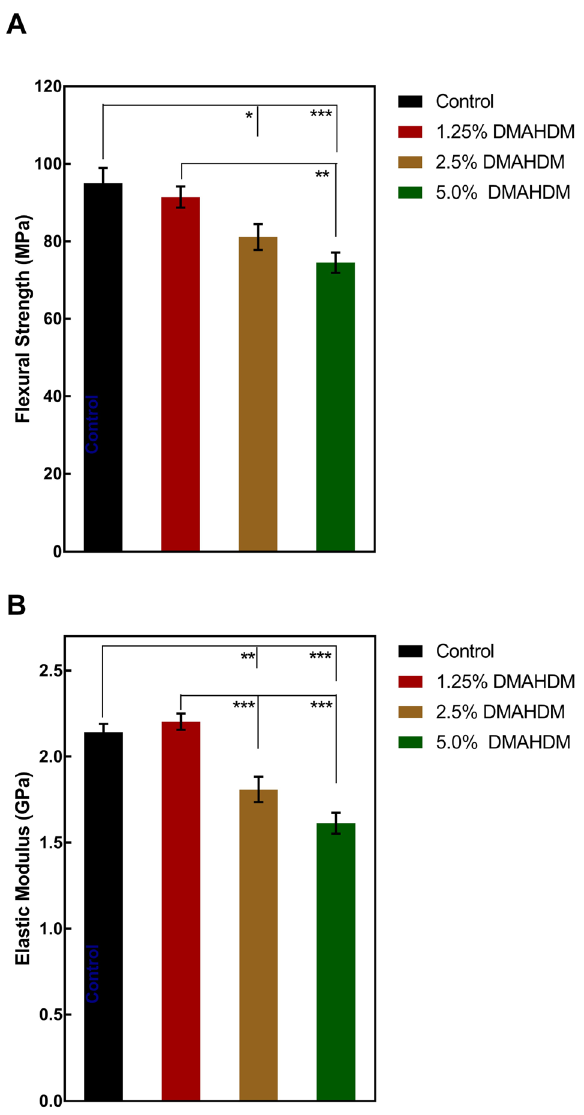
Fig. 3 Mechanical properties of composites. A Flexural strength, and ( B ) elastic modulus (mean ± SD; n = 6). (* p < 0.05. ** p < 0.01. *** p < 0.001)